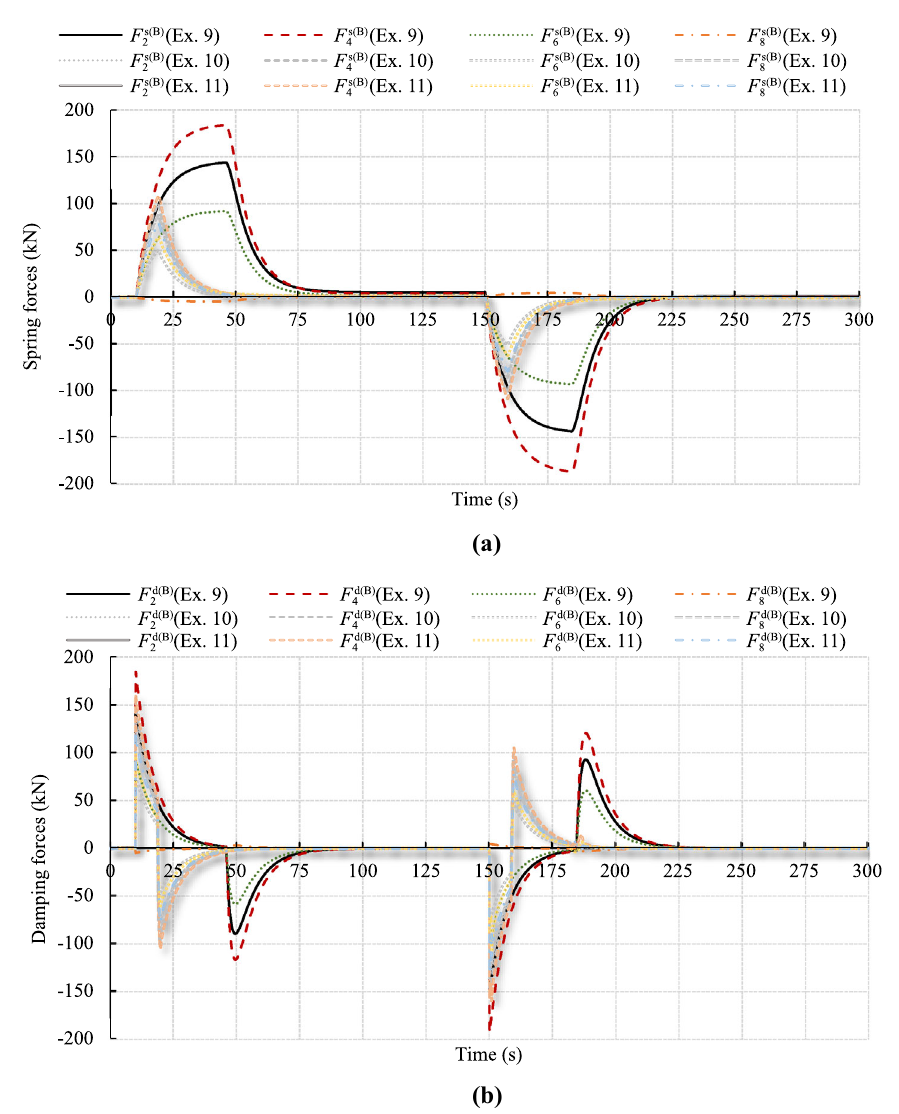
Fig. 16 Simulation results based on the LTD for model A of the MUT: a secondary suspension spring forces F s B ð Þ b secondary suspension damping forces F d B ð Þ and active vibration damping are